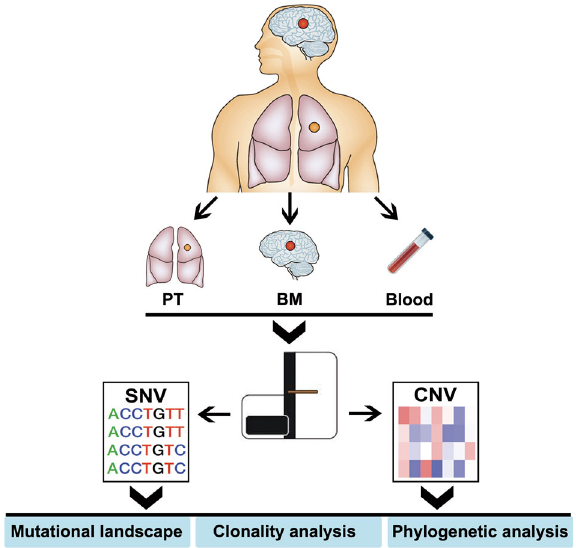
Fig. 1 Flowchart of sample collection and experimental procedure. PT primary tumor, BM brain